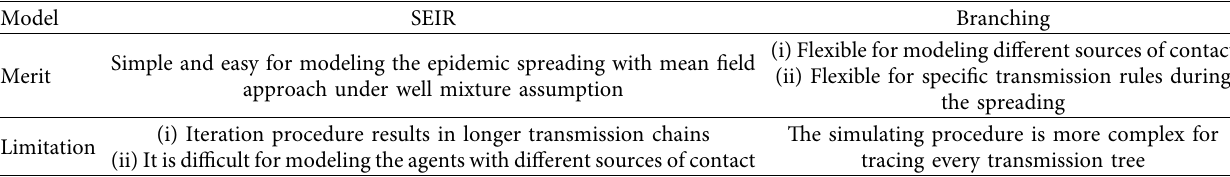
Table 1: The comparison of SEIR and branching in modeling COVID-19 in well-prevented